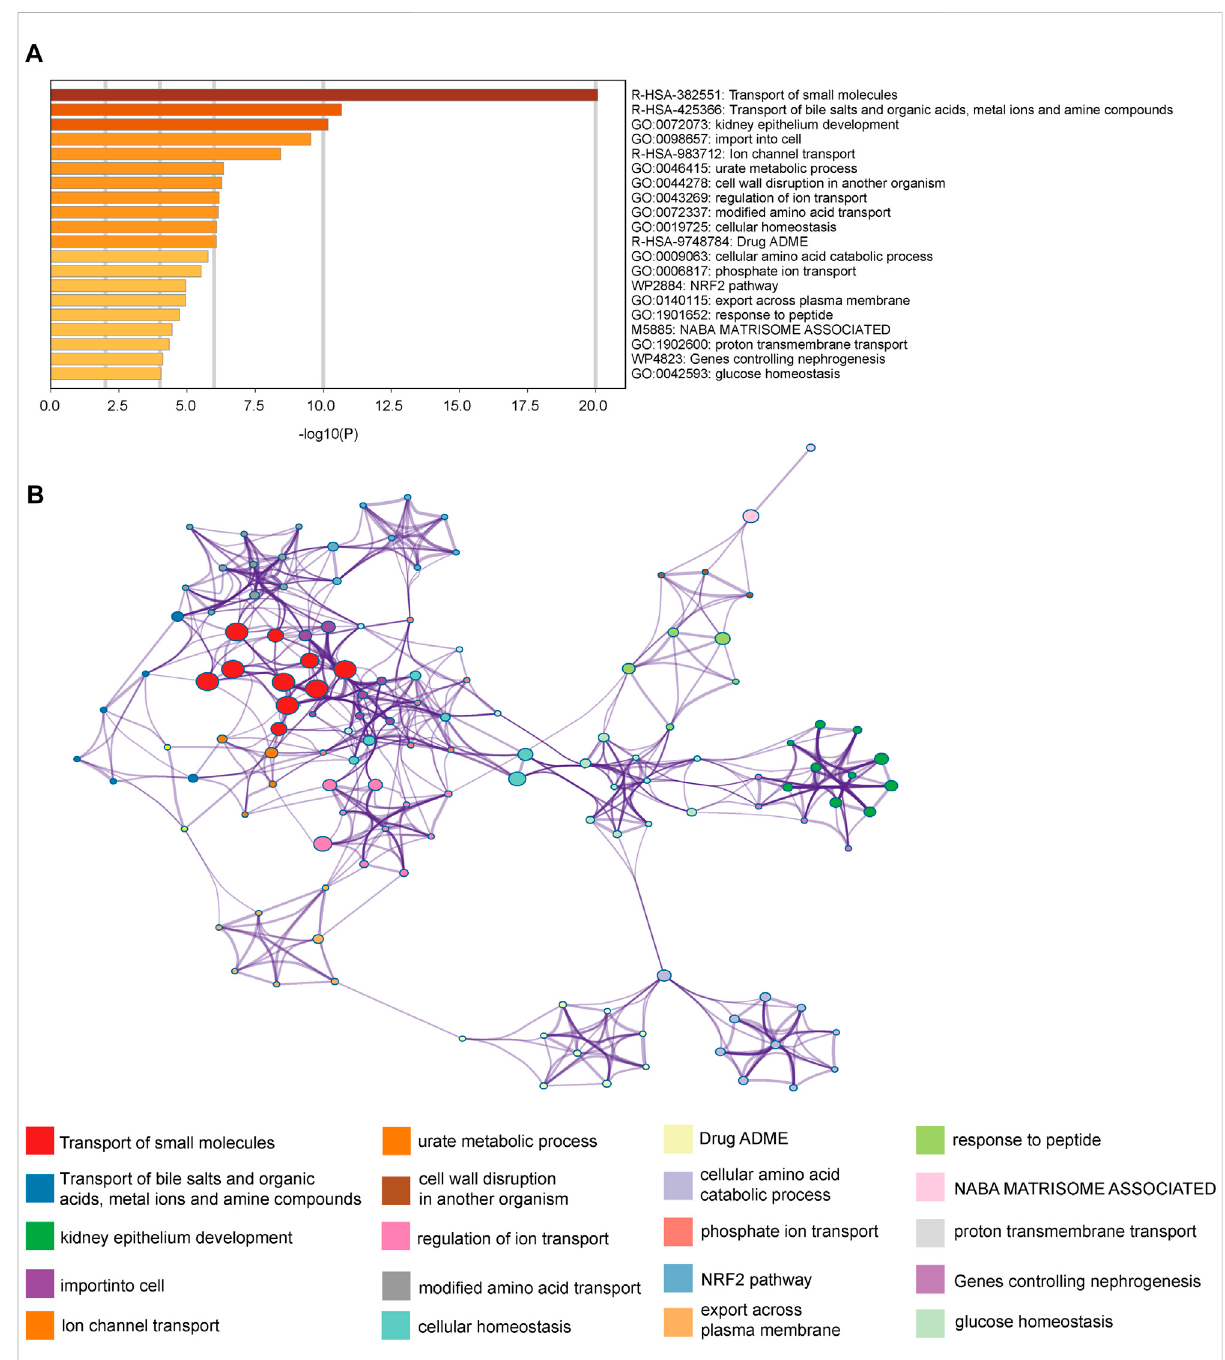
FIGURE 3 Enrichment analysis revealed the biology functions mediated by module component genes. (A) Enrichment terms of the MElightgreen module component genes. (B) Network of the enriched pathways.